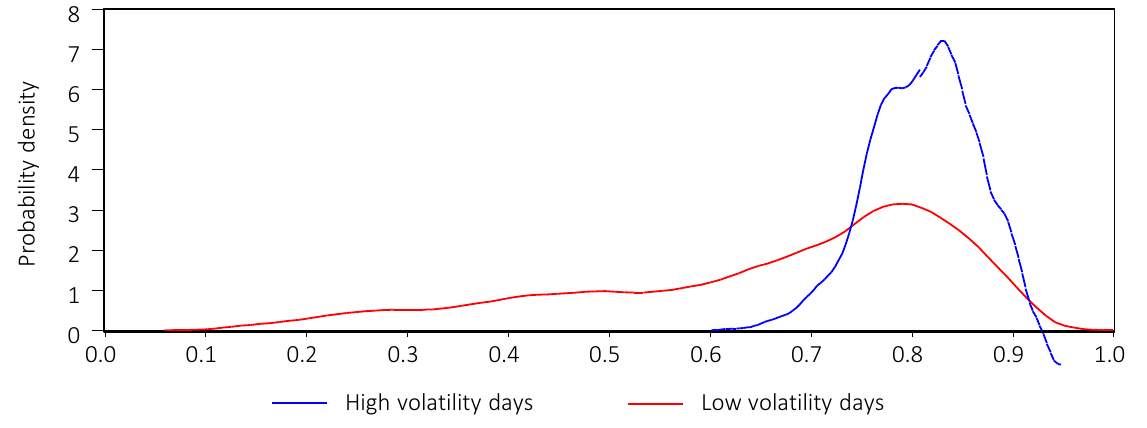
Figure 2(c). Distributions of DCC between New York and Tokyo gold markets on low and high volatility days